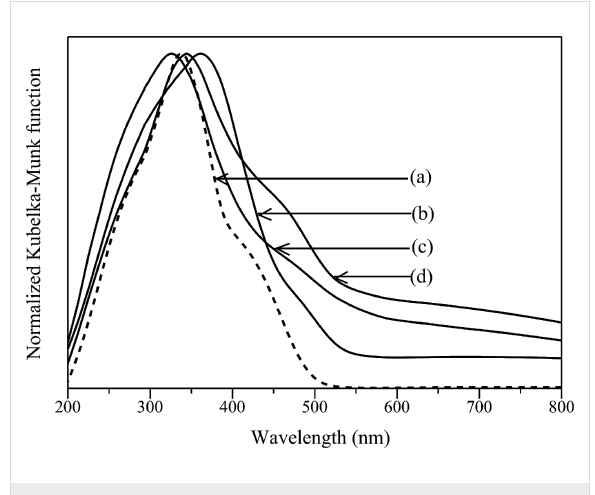
Figure 5: DR UV–visible spectra of (a) Cd 0.1 Zn 0.9 S, (b) Ag(0.01)- doped Cd 0.1 Zn 0.9 S, (c) Ag(0.03)-doped Cd 0.1 Zn 0.9 S (d) Ag(0.05)- doped Cd 0.1 Zn 0.9 S prepared by the hydrothermal